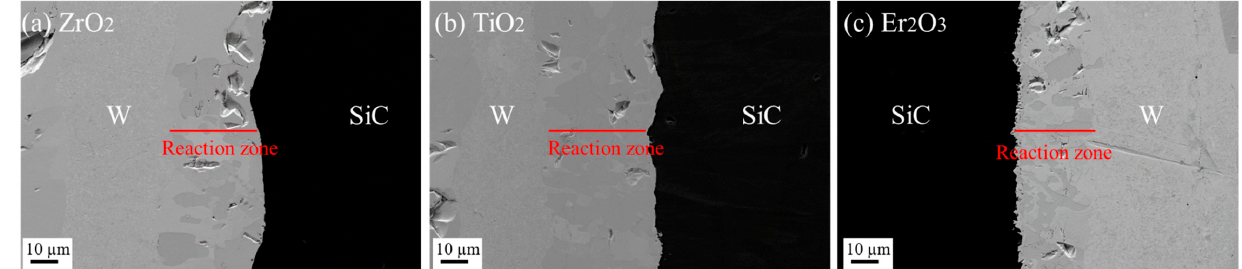
Figure 5. SEM images of cross-section of W joined with dipped oxide-coated SiC by 1-time dipping after 1700 °C, 20 MPa for 1 h heat treatment. ( a ) Cross-sectional image of dipped ZrO 2 -coated SiC joined with W; ( b ) Cross-sectional image of dipped A-TiO 2 -coated SiC joined with W; ( c ) Cross- sectional image of dipped Er 2 O 3 -coated SiC joined with W.